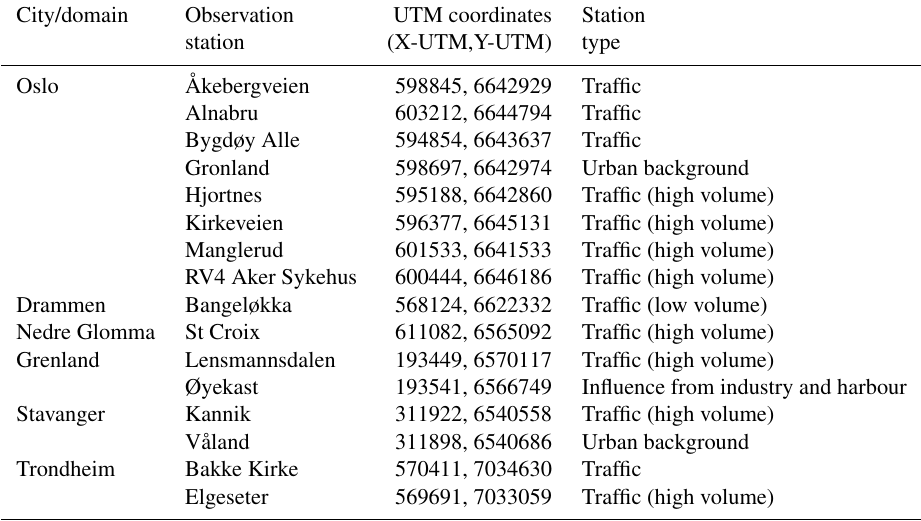
Table 7. Observation stations used in the evaluation of the EPISODE model results for the six different city domains. The location of each station is shown in UTM coordinates along with the corresponding UTM